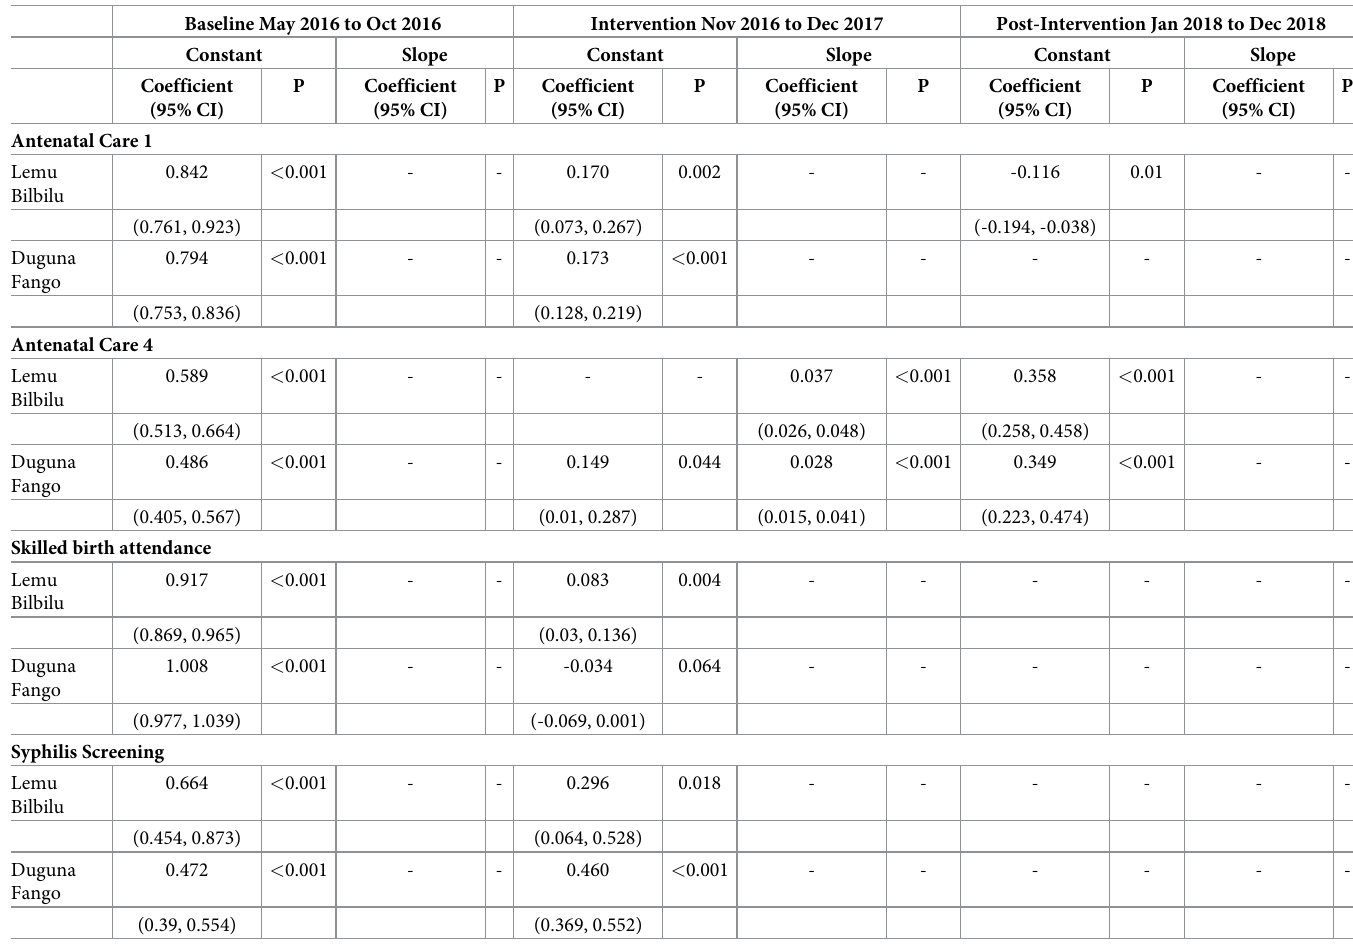
Table 3. Results of the time series analysis for the verification factor for the core measures across woreda over the baseline, intervention and post-intervention